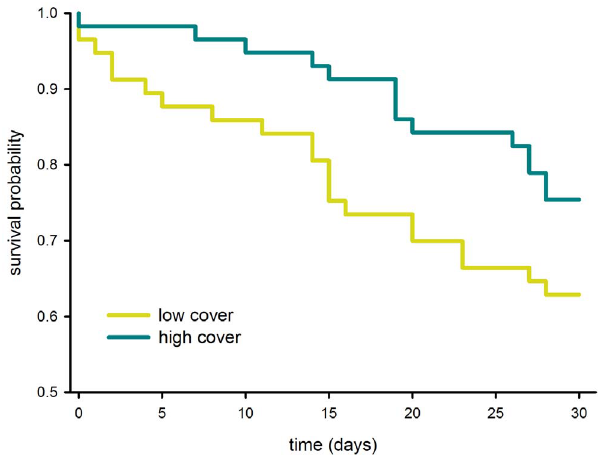
Figure 6. Survival plot from a Cox proportional hazards model with ‘‘vegetation cover’’ fitted as fixed effect. To highlight the effect of vegetation cover on nest survival the original dataset was split into ‘‘high’’ and ‘‘low’’ values of vegetation cover (according to the median) and plotted in two survival plots. Note that the two models represented here do not correspond to the Mixed-effects Cox proportional hazards models shown in Table 1.